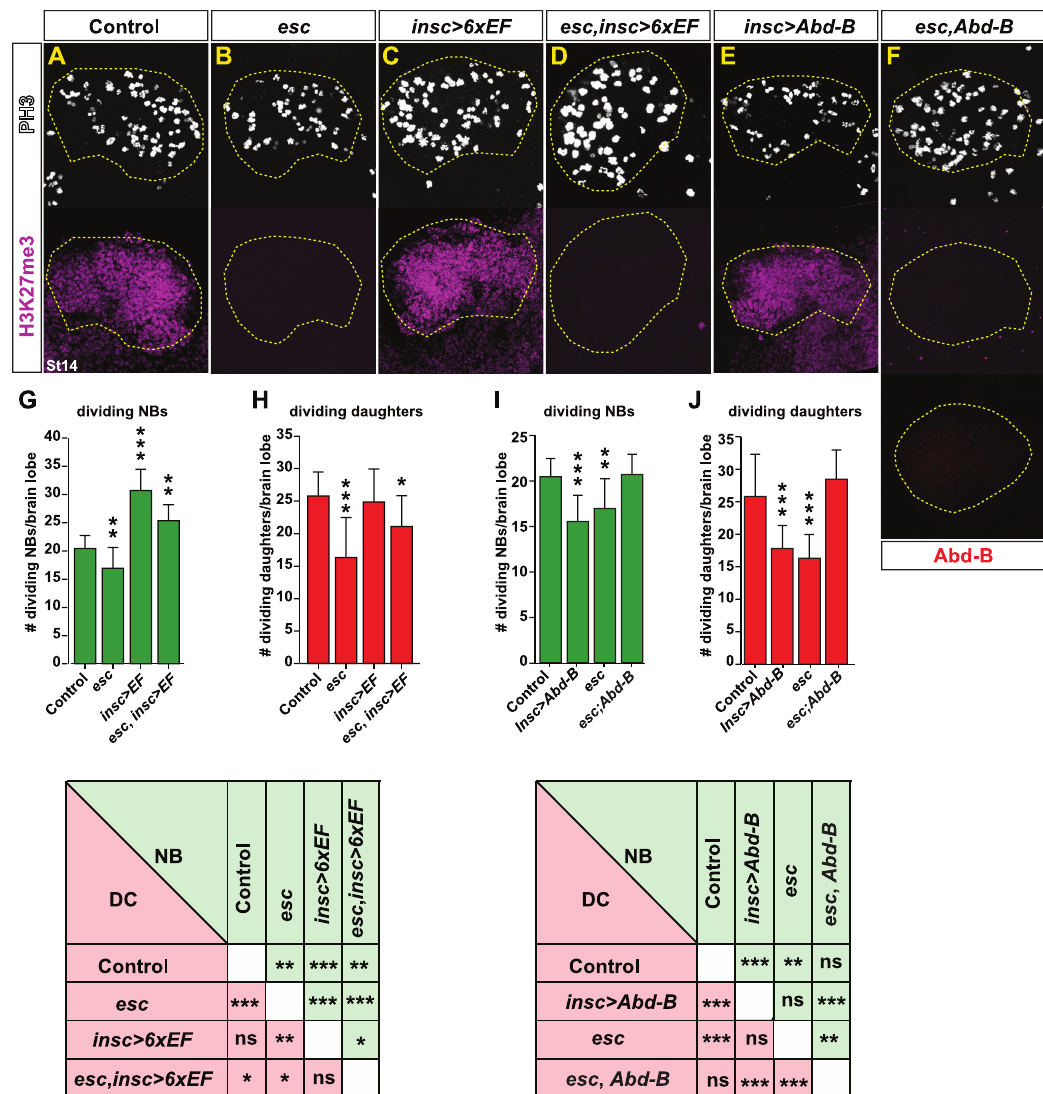
Fig 5. 6xEF expression or Abd-B mutation rescues PRC2 mutants. (A–F) PH3 (proliferation) and H3K27me3 staining, as well as Abd-B (F) expression, in control, esc , and esc with 6xEF cross-rescue, as well as Abd-B misexpression and esc;Abd-B double mutants, at St14 in segments B1–B3. (G–J) Quantification of dividing NBs and daughter cells, segments B1–B3, at St14 ( � p � 0.05, �� p � 0.01, ��� p � 0.001, Student two-tailed t test; n = 10 embryos; ± SD). The numerical data underlying this figure are included in S1 Data. Genotypes: (A) OregonR . (B) esc 5 or esc 21 over esc Df ( Df(2L)Exel6030 ). (C) insc-Gal4/UAS-6xEF . (D) esc 5 or esc 21